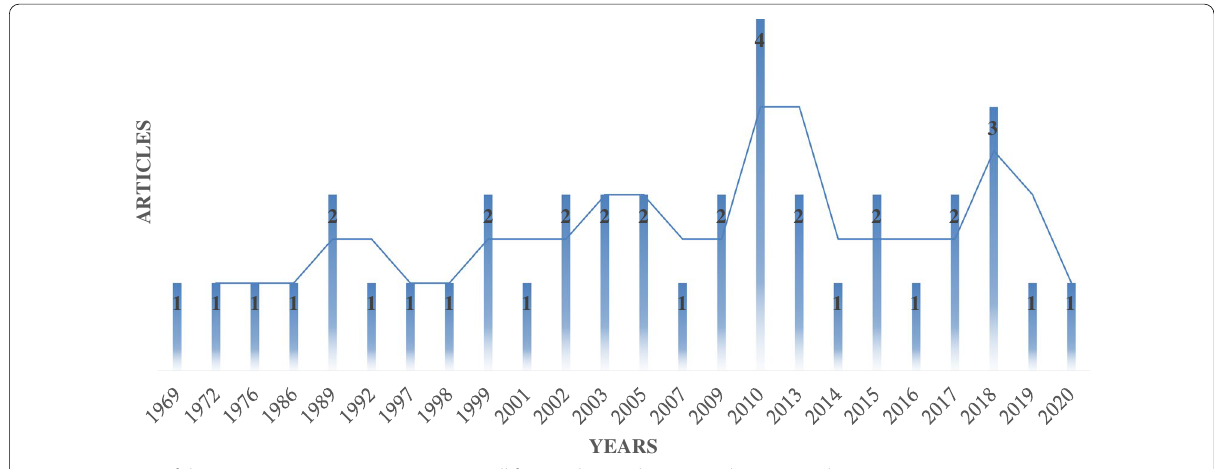
Fig. 2 Overview of the year metrics on Wastewater AND Cell free nucleic acid OR extra-chromosomal